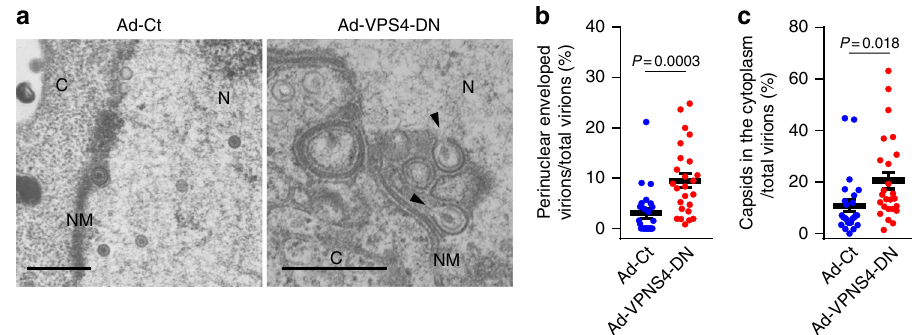
Fig. 7 Ectopic expression of the dominant-negative mutant of VPS4 inhibits HSV-1 nuclear egress. a Electron microscope images of HeLa cells co-infected with HSV-1 and either control recombinant adenovirus (Ad-Ct) or recombinant adenovirus expressing Flag-VPS4-DN (Ad-VPS4-DN). Cells were infected with Ad-Ct or Ad-VPS4-DN for 4 h and then co-infected with HSV-1 for 22 h. Arrowheads indicate virions defective in scission steps in the aberrant invagination structures derived from the INM. C cytoplasm, N nucleus, NM nuclear membrane. Bars, 500 nm. Images are representative of three independent experiments. The percent of ( b ) perinuclear enveloped virions and c capsids in the cytoplasm of the cells in the experiment in ( a ) were determined. Data are shown as the mean ± SEM for 25 cells and are representative of three independent experiments. The indicated P -values were obtained using the Tukey ’ s test ( b ,